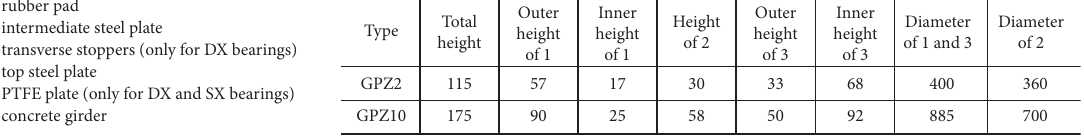
Table A.1 Dimensions of each part of pot rubber bearings (unit: